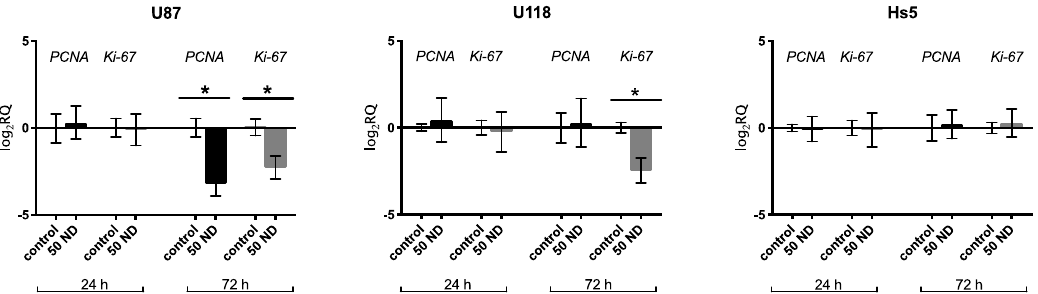
Figure 6. Analysis of the mRNA expression level of PCNA and Ki-67 after ND treatment at 50 μ g/mL concentration for 24 and 72 h in U87, U118, and Hs5 cells. Groups marked with an asterisk (*) are significantly different ( p < 0.05). The results are calculated relative to the control values. Log 2 RQ values for all genes are normalized to the TBP housekeeping gene. PCNA , proliferating cell nuclear antigen; TBP , TATA box binding protein.